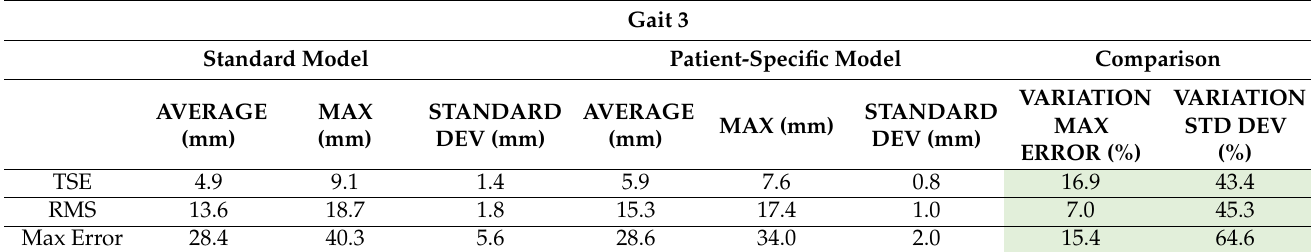
Table 2. Mean, Maximum value and Standard Deviation in Gait